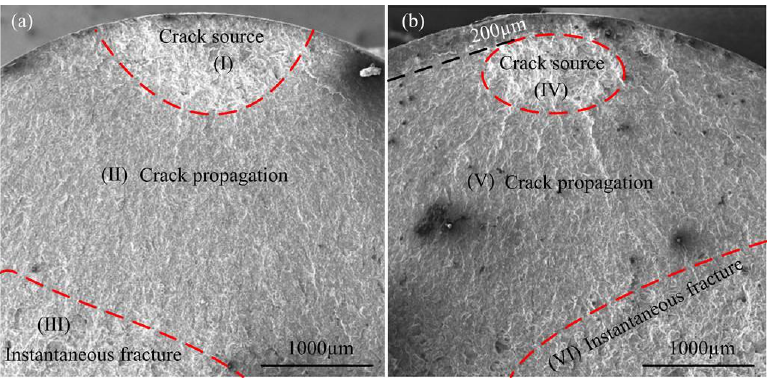
Figure 10. Fracture surfaces of as-received and HFIR specimen. ( a ) as-received specimens and ( b ) HFIR specimens.